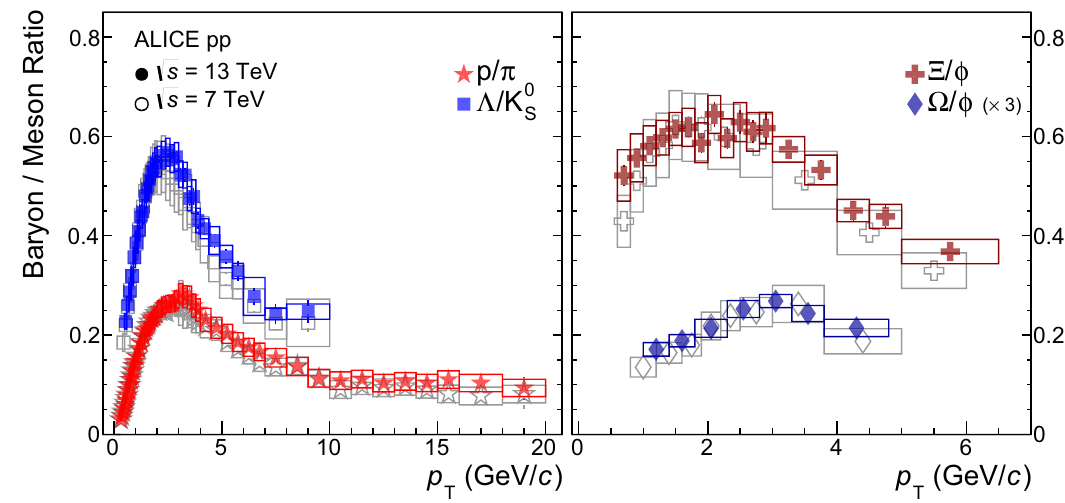
√ s = 13 (full symbols) and 7 TeV [25,27]